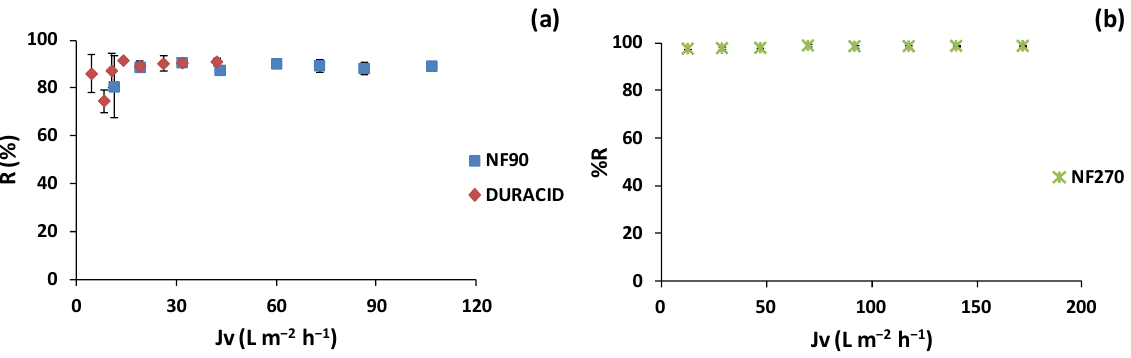
Figure 3. Polyphenol rejection evolution with trans-membrane flux for ( a ) lees filters with NF90 and Duracid membranes and ( b ) olive pomace extracts with NF270 membrane. For the olive pomace extracts (Figure 3b), the NF270 membrane reached the highest